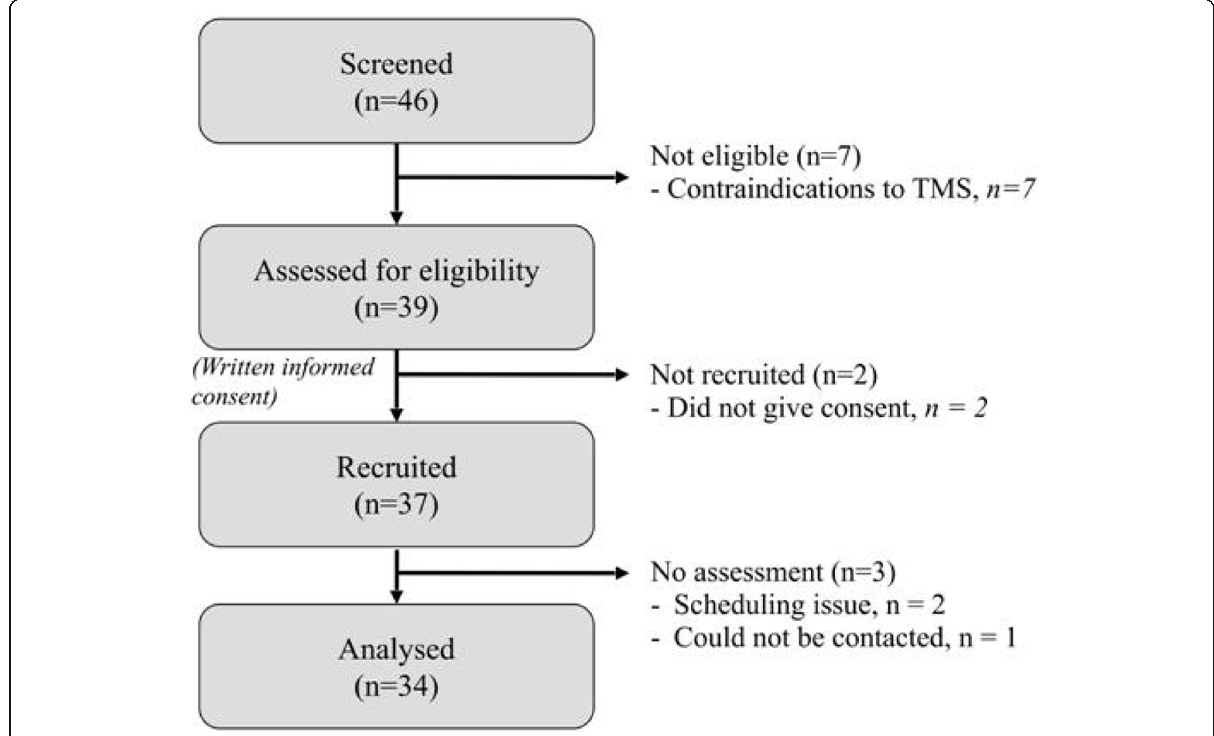
Fig. 1 Strengthening the reporting of observational studies in epidemiology 2007 (STROBE) flow chart. TMS Transcranial magnetic